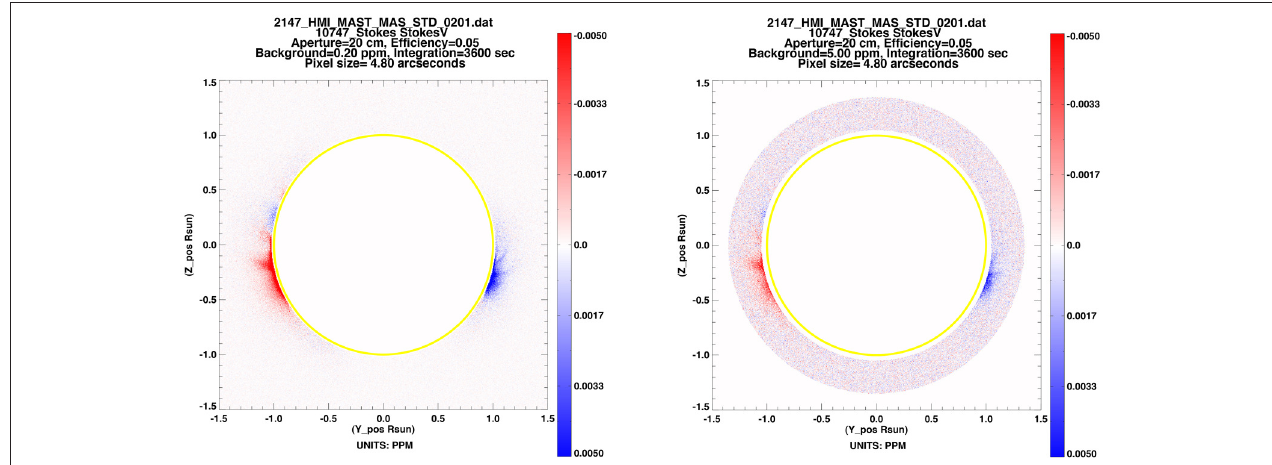
FIGURE 2 | Comparison of forward-modeled circular polarization for a global coronal MHD model (Predictive Science Inc. MAS model for Carrington Rotation 2147, from http://www.predsci.com/hmi/data_access.php), and applying the FORWARD SolarSoft codes (http://www.hao.ucar.edu/ FORWARD/). Photon noise is added based on telescope aperture, efficiency, background, pixel size, and integration time. Left: Background 0.2 µ B , appropriate for WAMIS), Right: Background 5 PPM (appropriate for CoMP), all integrated for 1h. WAMIS vs. CoMP FOVs are explicitly applied to these = ⊙ images as internal/external occulters (at 1.02/1.05, 2.8/1.35 R respectively). Note that sources of systematic errors are not considered, but are expected to be ⊙ significant since the signal shown here is on the order of 0.1% of intensity.